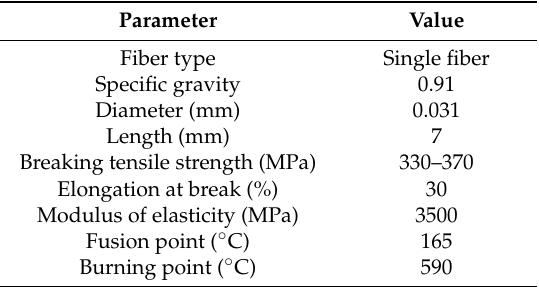
Table 1. Performance parameters of polypropylene fiber.